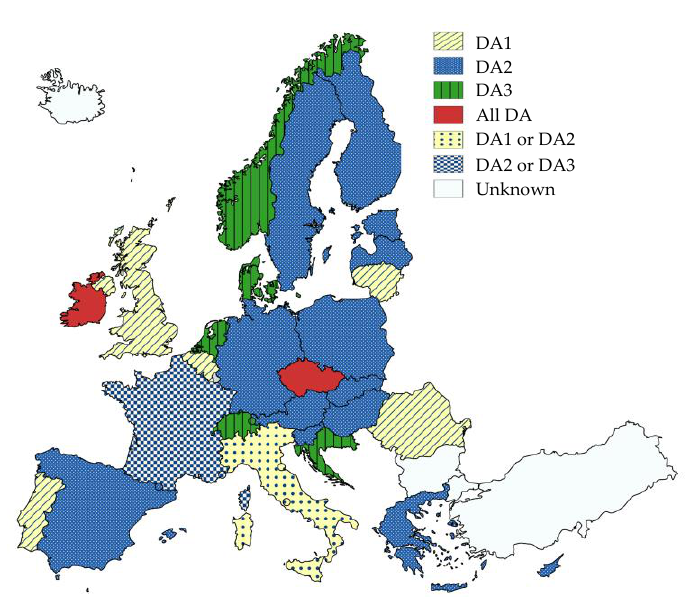
Figure 2. Design Approaches in the European member states for the design of shallow foundations. Table 2. Partial factors for GEO ultimate limit states.